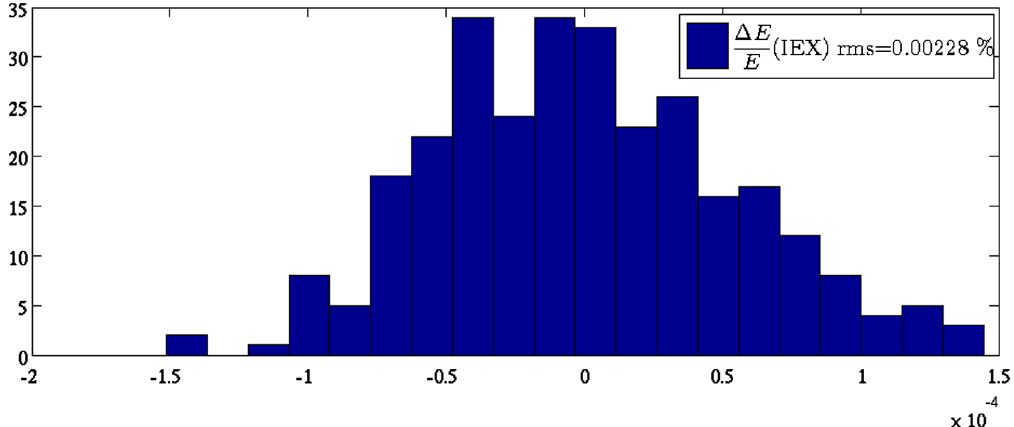
FIG. 5. Energy jitter